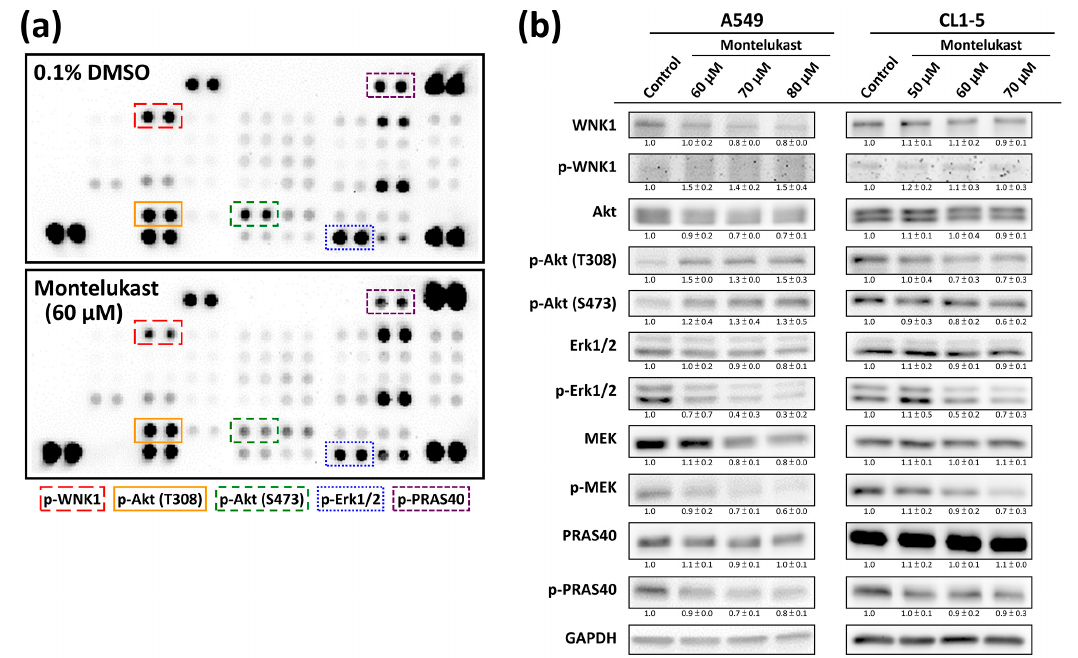
Figure 5. Montelukast decreased the phosphorylation of With No Lysine 1 (WNK1), protein kinase B (Akt), Extracellular Signal-Regulated Kinase 1/2 (Erk1/2), MAPK/Erk kinase (MEK), and Proline-Rich Akt Substrate of 40-kDa (PRAS40) in lung cancer cells. ( a ) The CL1-5 cells were treated with 0.1% DMSO (control) or 60 μ M montelukast for 8 h. The levels of protein phosphorylation in the cell lysates were assessed with a Human Phospho-Kinase Array Kit; ( b ) The cells (A549 and CL1-5) were treated with 0.1% DMSO (control) or various concentrations of montelukast for 8 h. The phosphorylated and total protein levels in the cell lysates were assessed with an immunoblot assay. The results shown are representatives of at least three independent experiments performed on different days, along with the means ± SD of the relative expression levels to the corresponding control groups at the same time point.